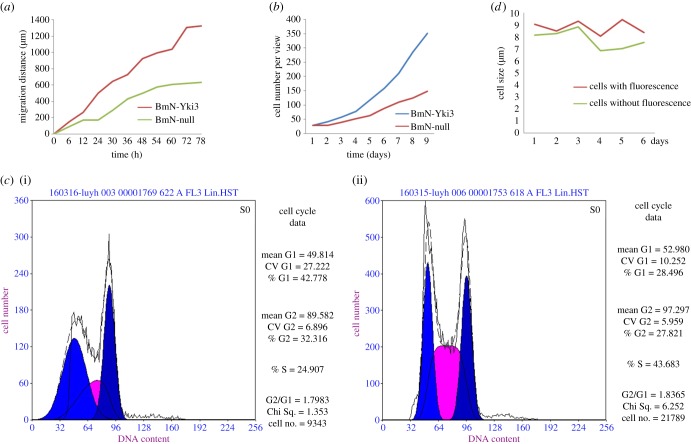
Effect of overexpression of the BmYki3 gene on cell size, cell migration and cell proliferation. (a) Effect of overexpression of the BmYki3 gene on cell migration; BmN-Yki3, the transformed cells overexpressing the BmYki3 gene, BmN-null, the transformed cells with pIZT/V5-His. (b) Effect of overexpression of the BmYki3 gene on cell proliferation. (c) Effect of overexpression of the BmYki3 gene on cell cycle: (i) BmN-null transformed cells and (ii) BmN-Yki3 transformed cells. (d) Effect of overexpression of the BmYki3 gene on cell size, the BmN cells were transfected with pIZT/V5-His-BmYki3, the size of cells with/without fluorescence was determined daily.